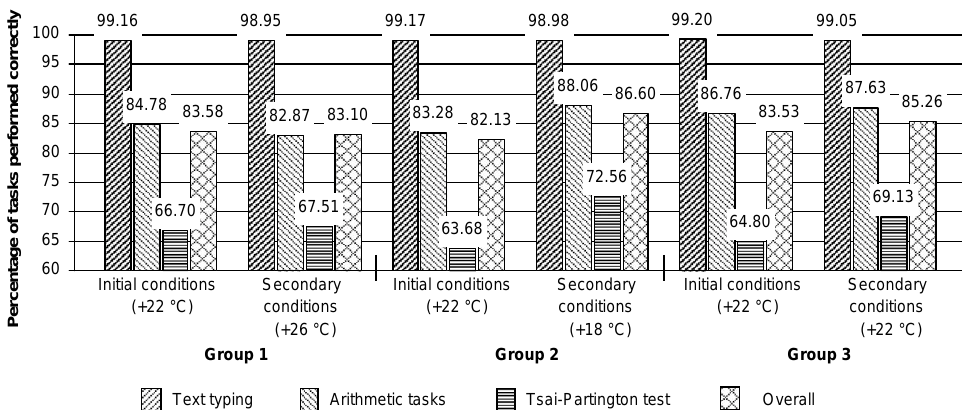
Fig. 4. Work performance expressed from the accuracy of the tests performed by all three groups of